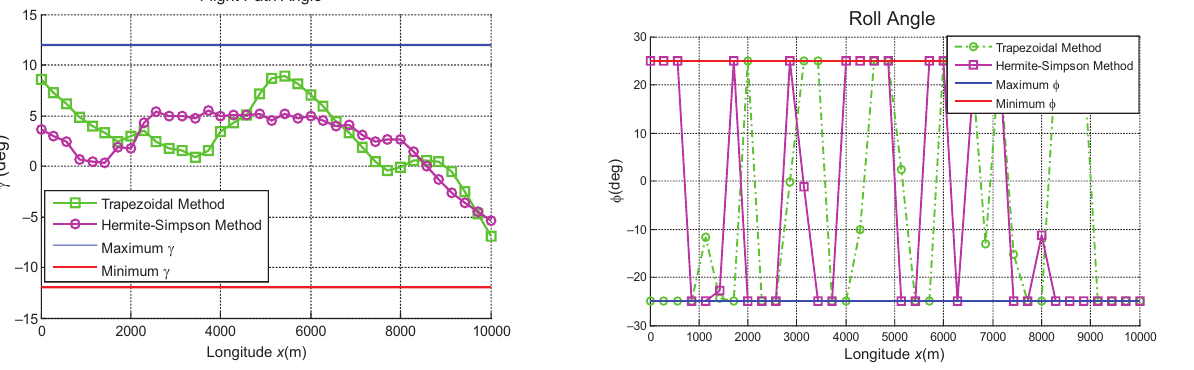
Figure 9. History of the roll angle